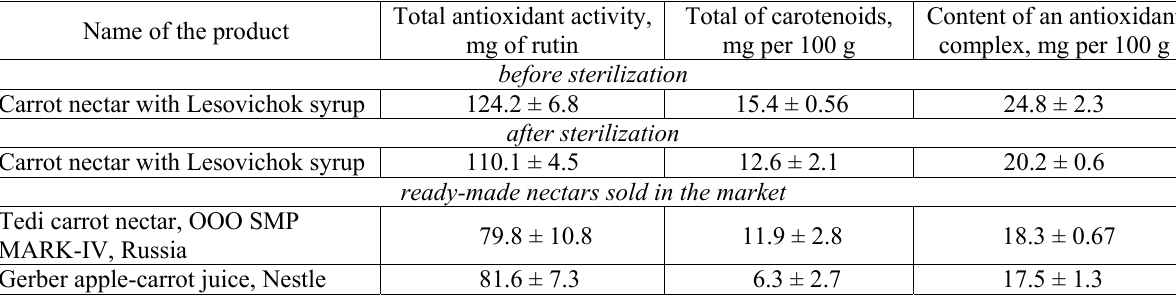
Table 8. Antioxidant activity of ready-made carrot nectar Name of the